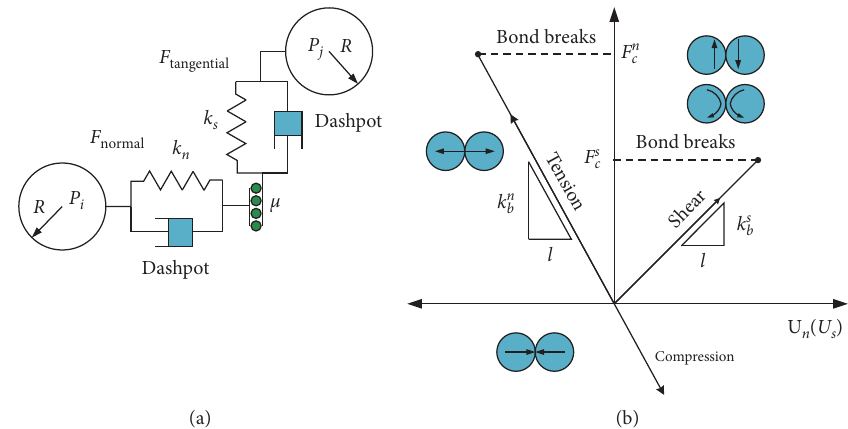
Figure 1: (a) The particle contact model in the DEM; (b) constitutive behavior in the contact bonding model.